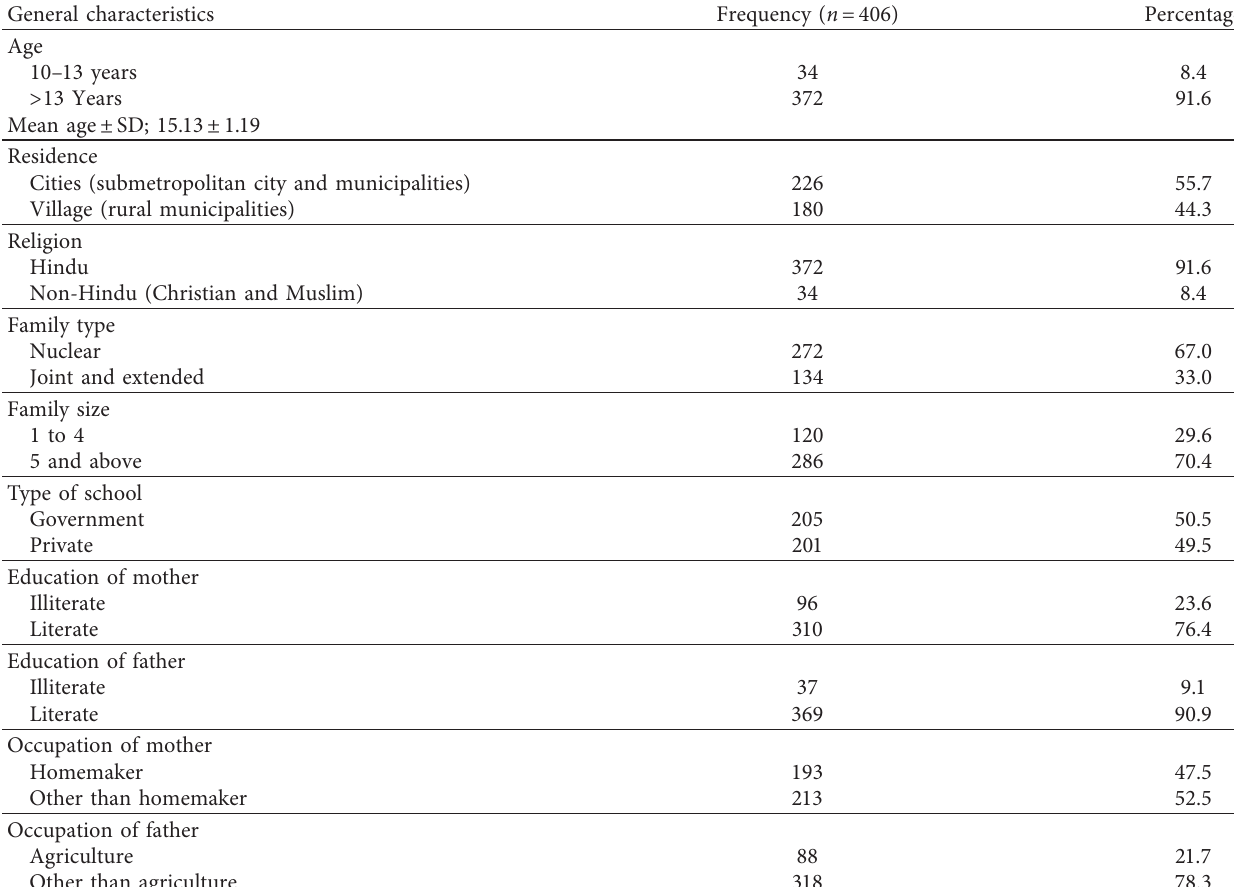
Table 1: Distribution of background related characteristics of study population.